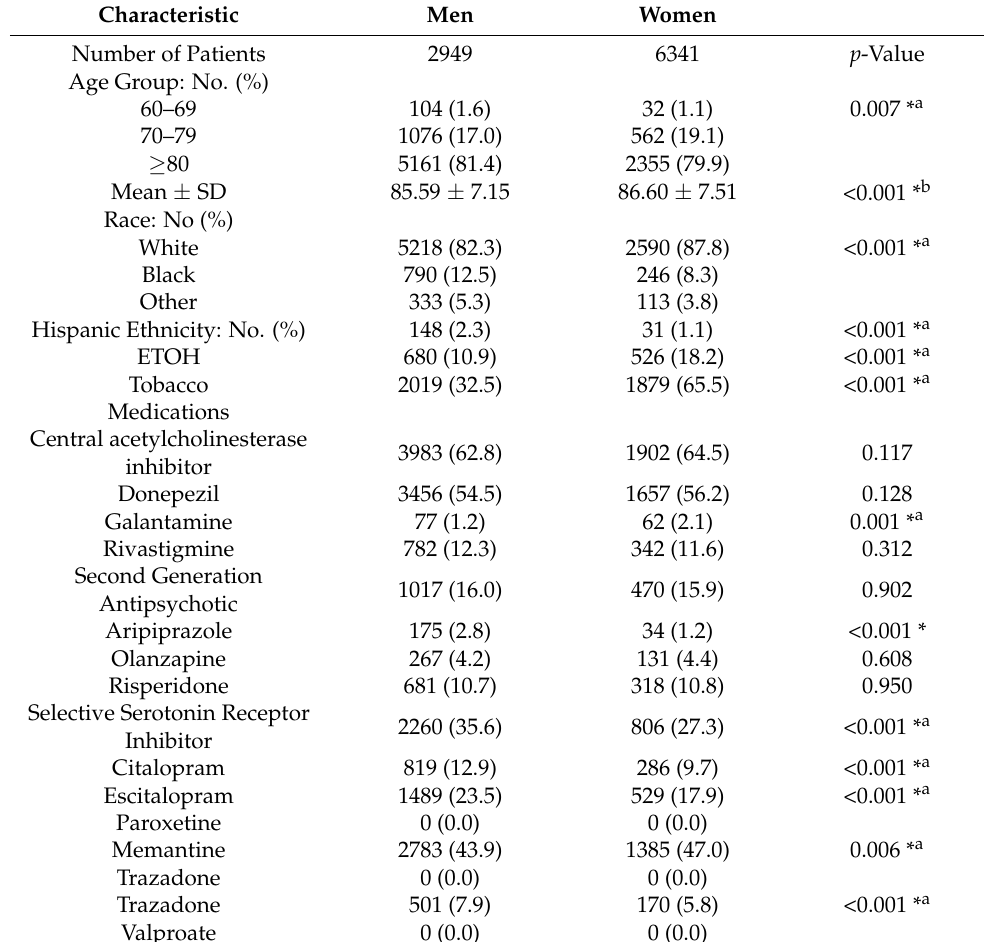
Table 1. Comparison of Demographic and Clinical Characteristics of Late-Onset Alzheimer’s Dis- ease